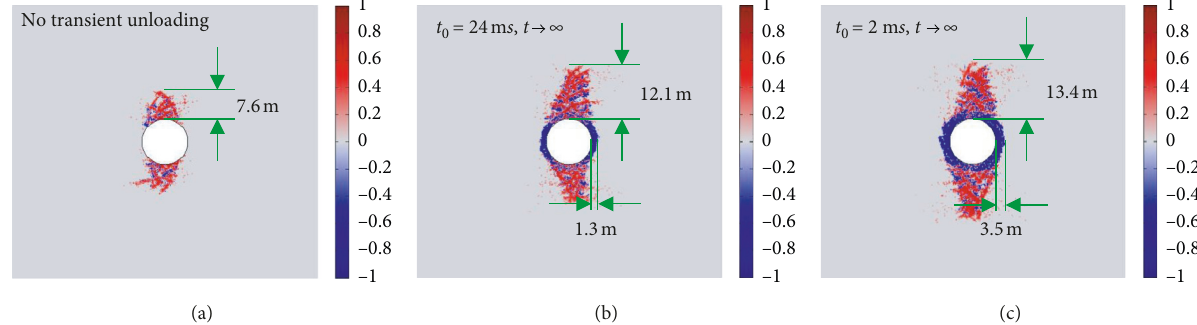
Figure 7: Final damage zone distribution under different unloading durations and without considering transient unloading ( κ � 2) [131].